Question: How would you classify this visualization?
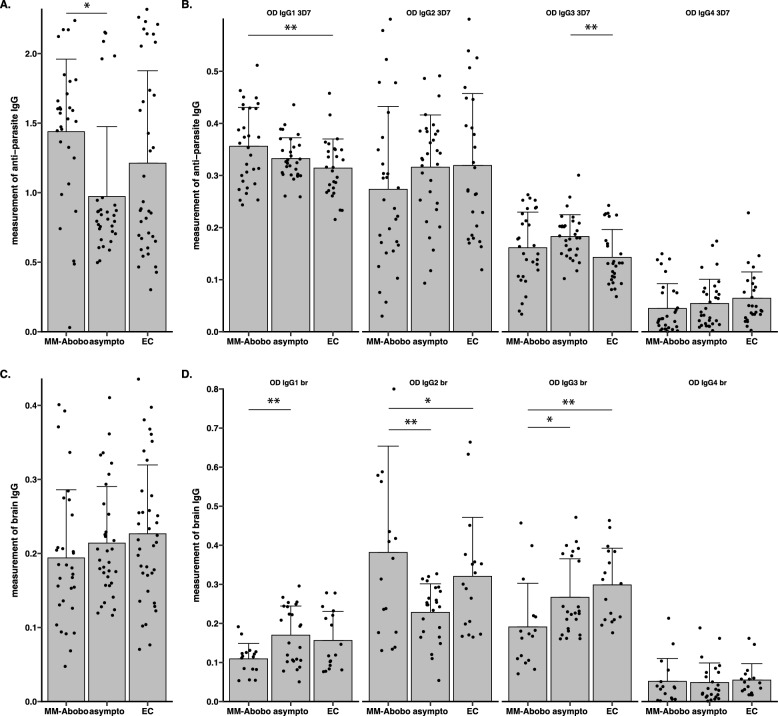
Answer: box